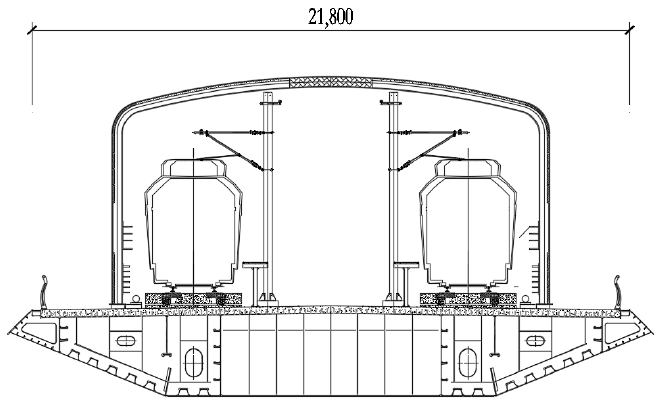
Figure 2. Cross-sectional view of the main beam (unit: mm).